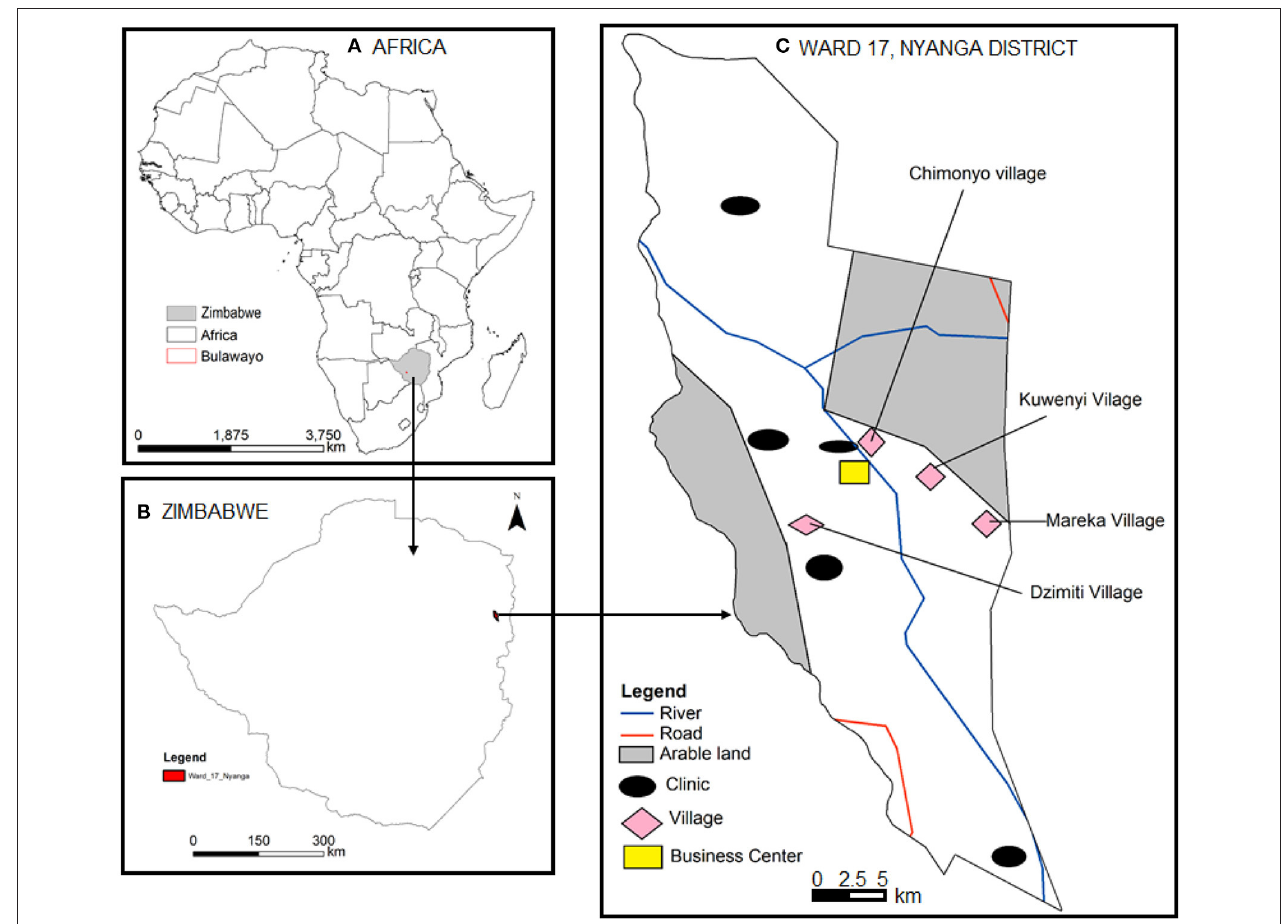
FIGURE 1 | Location of Zimbabwe in Africa (A) , study area in Zimbabwe (B) , and map of Ward 17 of Nyanga District (C)